Question: From the figure, is the trend upward or downward?
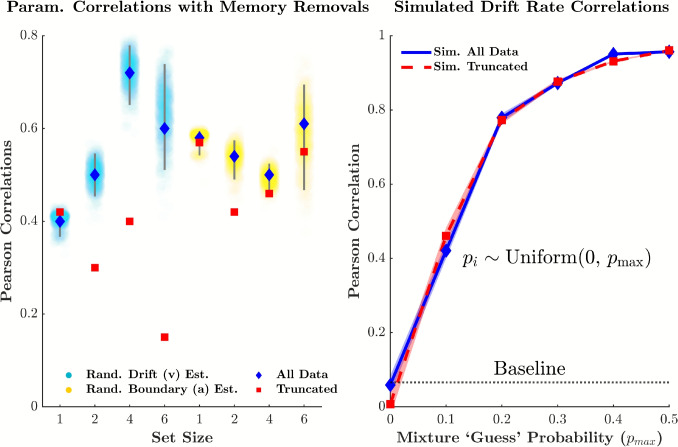
Answer: increasing